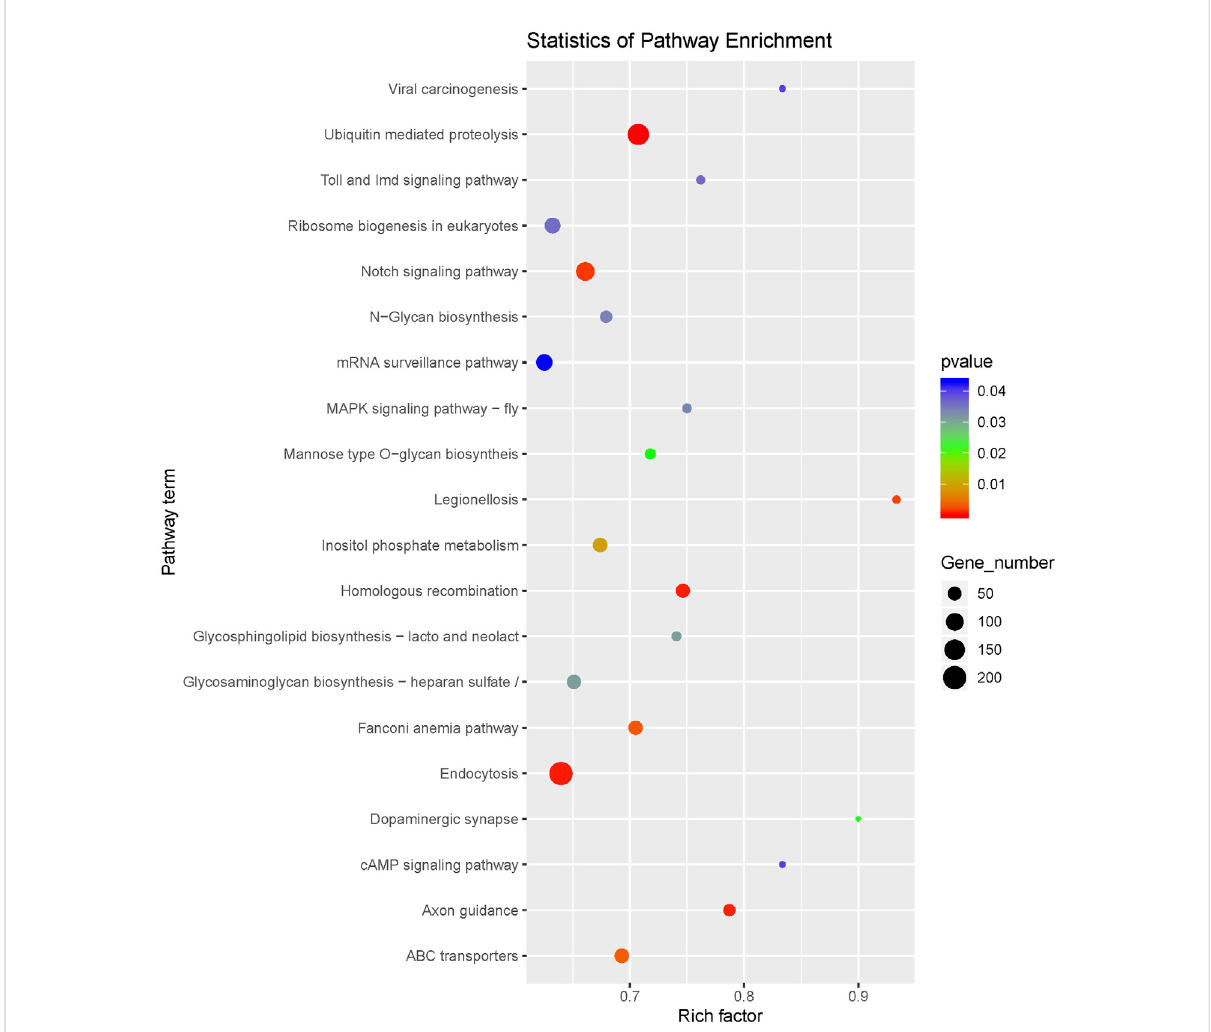
FIGURE 3 KEGG pathway enrichment of the target genes of differentially expressed